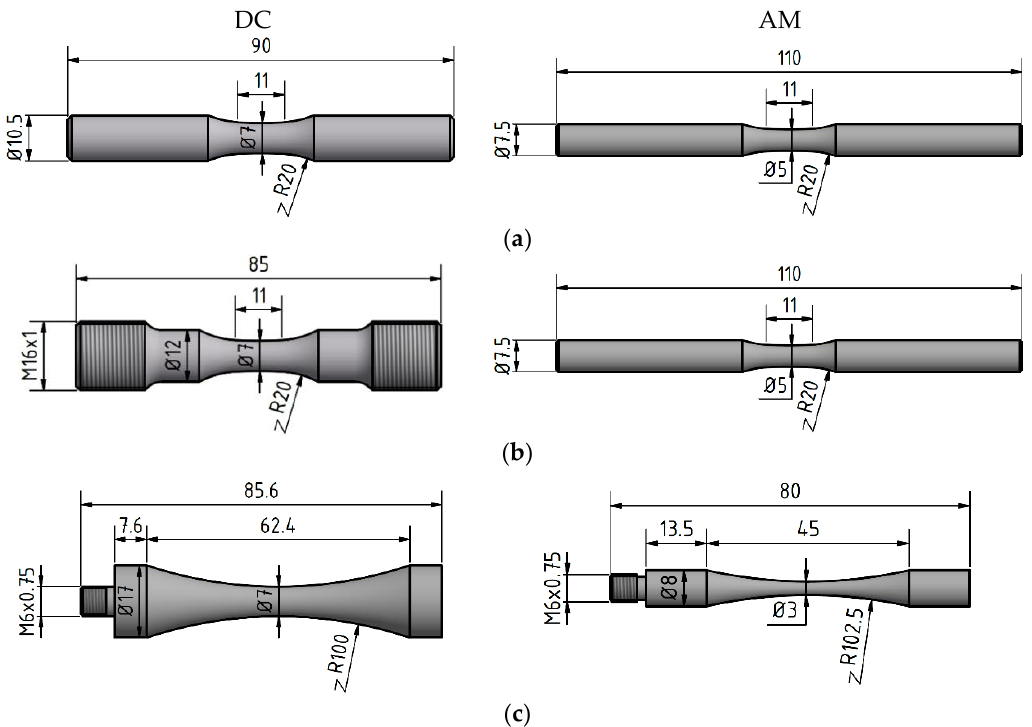
Figure 3. Specimen geometries for ( a ) quasi-static, ( b ) HCF and ( c ) VHCF testing of die-cast (DC) alloy (left) and additively manufactured (AM) alloy (right).